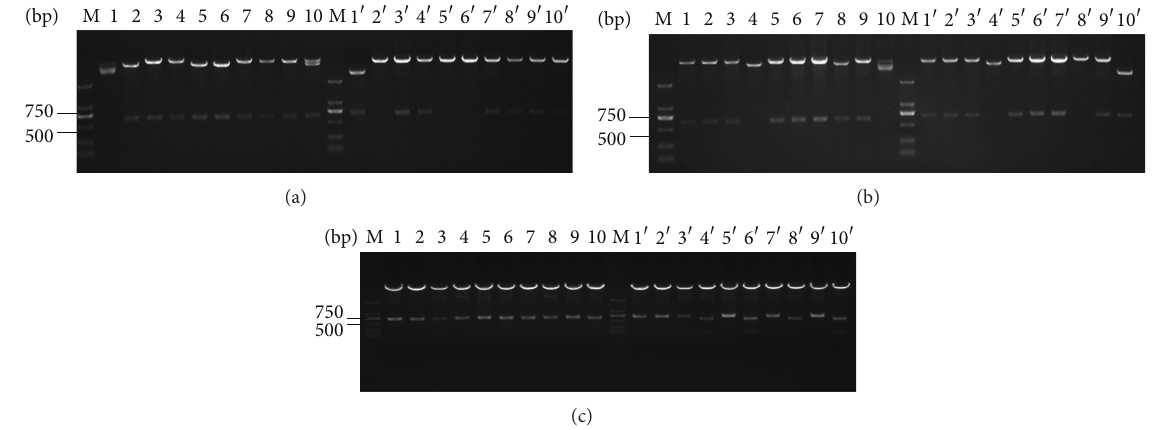
Figure 2: Verification of the Fab clones before and after panning by double-enzyme digestion. (a) Before panning, Fab clones (number 1 ∼ number 10) were digested by Xba I/Sac I (lanes 1 ∼ 10) and by Xho I/Spe I (lanes 1 󸀠 ∼ 10 󸀠 ); (b) before panning, Fab clones (number 11 ∼ number 20) were digested by Xba I/Sac I (lanes 1 ∼ 10) and by Xho I/Spe I (lanes 1 󸀠 ∼ 10 󸀠 ); (c) after panning, Fab clones (number 1 ∼ number 10) were digested by Xba I/Sac I (lanes 1 ∼ 10) and Xho I/Spe I (lanes 1 󸀠 ∼ 10 󸀠 ).